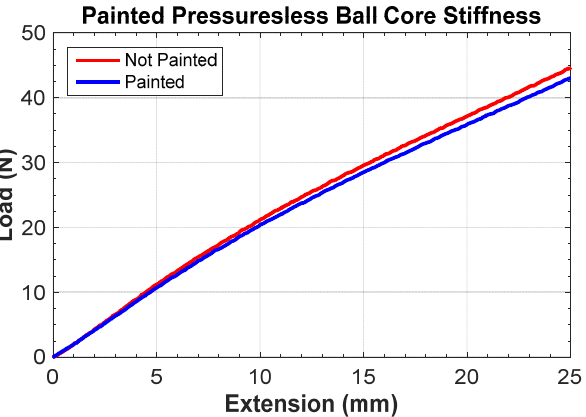
Figure 3. Effect of paint on the load ‐ extension response pressureless ball core rubber (mean of five repeats displayed for painted and non ‐ painted tensile samples).